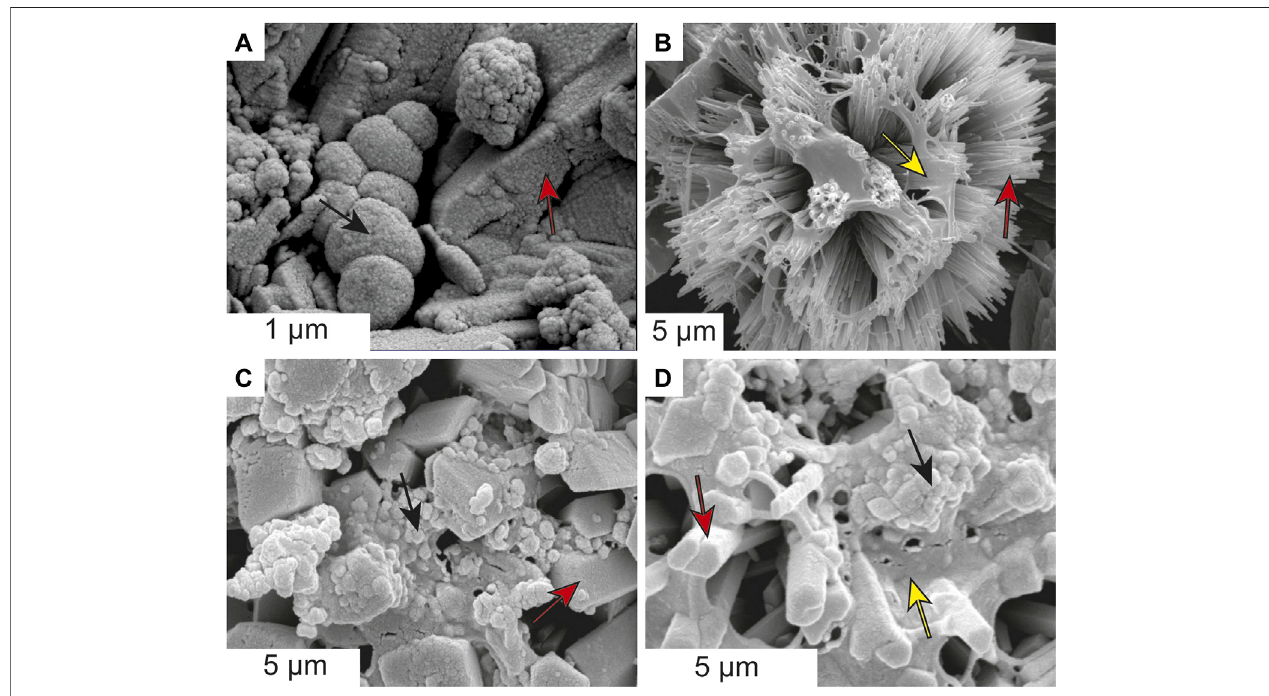
FIGURE 9 | The close association between nanocrystals, microbial bio fi lms and aragonite fi bers (A) Transition from nanocrystals (black arrow) to aragonite fi bers (red arrow) forming botryoidal aragonite, Abu Dhabi (B) Fibrous aragonite spherulite (red arrow) draped by bio fi lms EPS (yellow arrow) in Bagni San Filippo travertine (C) Nanocrystals(blackarrow)aspartsformingthearagonite fi bers(redarrow)ofspheruliticaragonite,GreatSaltLake (D) Coexistenceofnanocrystals(blackarrow),bio fi lm EPS (yellow arrow) and aragonite fi bers (red arrow) of spherulitic aragonite, Great Salt Lake.